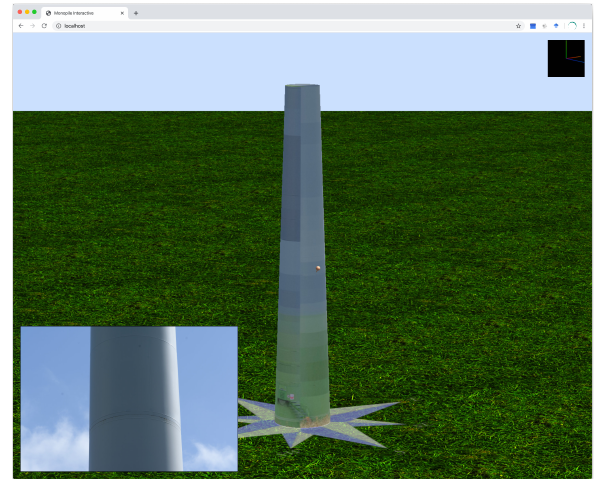
Figure 6. Visualization of the detected damage spots (yellow needle) using the 3D reconstruction of the wind turbine tower. The original images are linked to the 3D reconstruction and can be shown by clicking on the respective